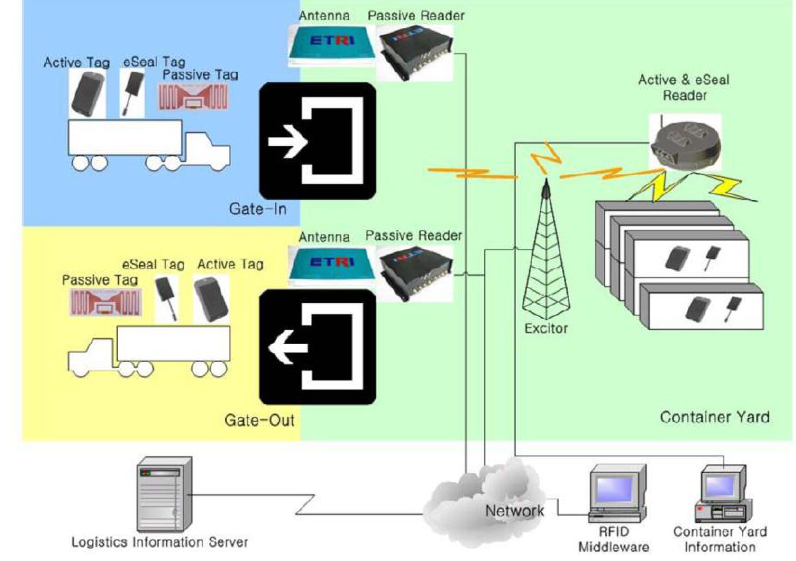
Figure 2. The structure of CYMS with RFID technologies (Park et al.,